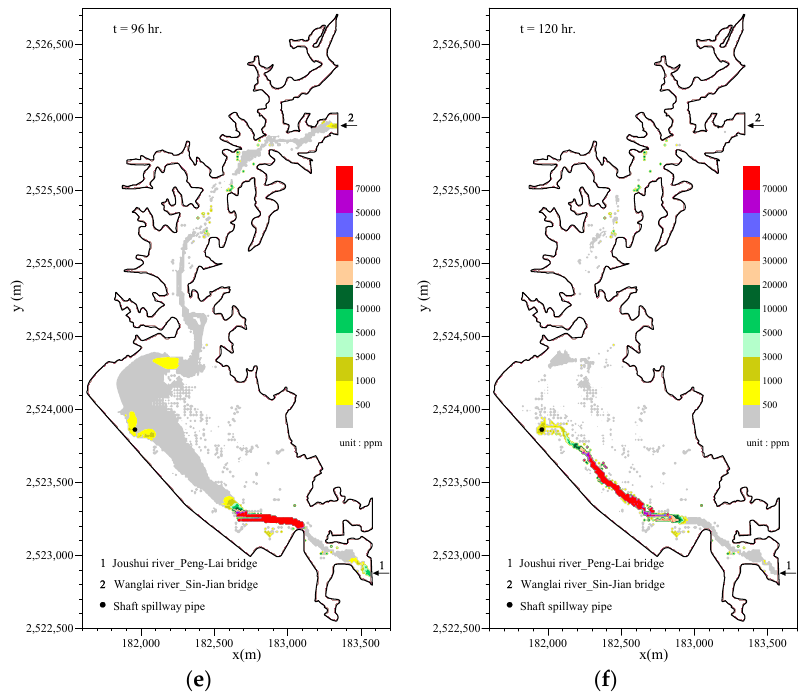
Figure 5. ( a ) Distribution of suspended sediment concentration at t = 36 h; ( b ) Distribution of suspended sediment concentration at t = 60 h; ( c ) Distribution of suspended sediment concentration at t = 72 h; ( d ) Distribution of suspended sediment concentration at t = 84 h; ( e ) Distribution of suspended sediment concentration at t = 96 h; and, ( f ) Distribution of suspended sediment concentration at t = 120 h.